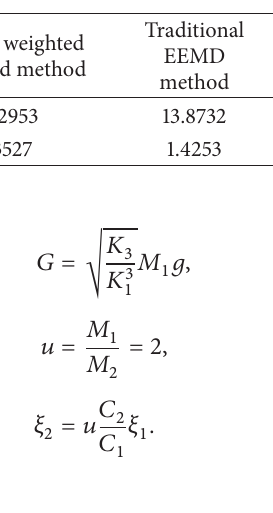
Table 2: The denoising results of the three methods: wavelet weigh- ted threshold method, traditional EEMD method, and the proposed